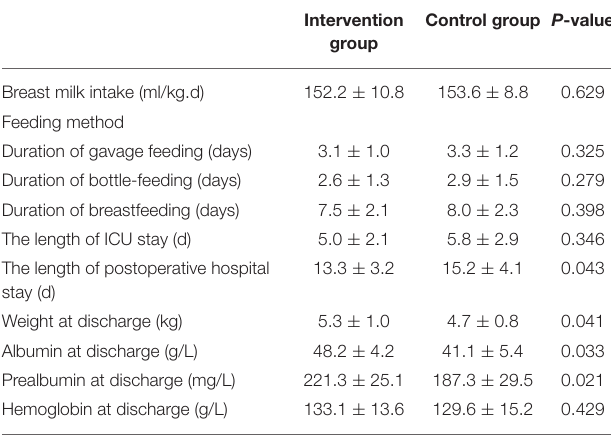
TABLE 3 | Comparison of the postoperative situation of the two groups.